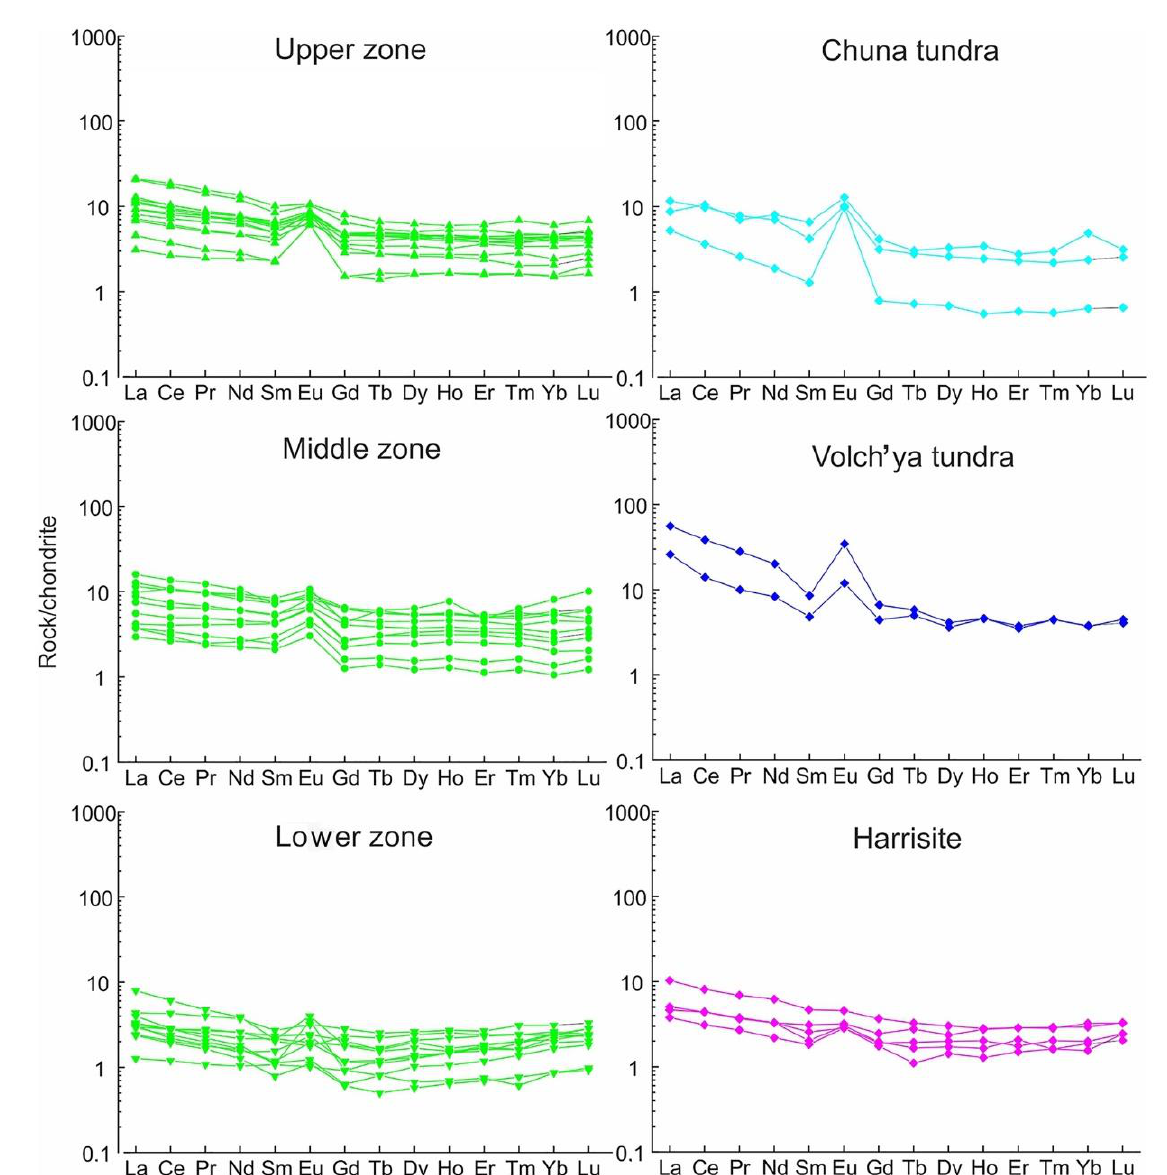
Figure 12. REE distribution in rocks of the massifs of Monchetundra, Chunatundra, and Volchetundra, as well as the harrisite, normalized to chondrite [33].